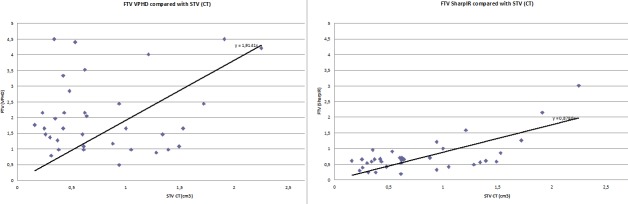
FTV compared to STV in LNs.FTV versus STV plotted for all LNs in VPHD (left) and SharpIR (right) in clinical ACE-PET/CT, with ROIs delineated with 42% threshold algorithm. The black lines represent the best linear regression, forced to include the origin.